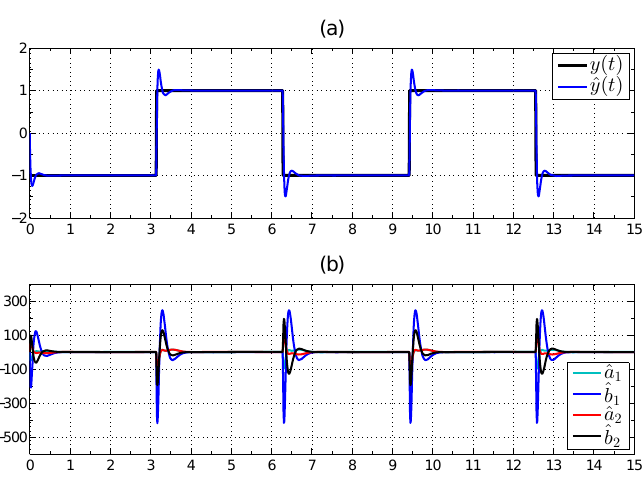
Figure 3. Example 2. ( a ) Square wave reconstruction and ( b ) Estimated coefficients.